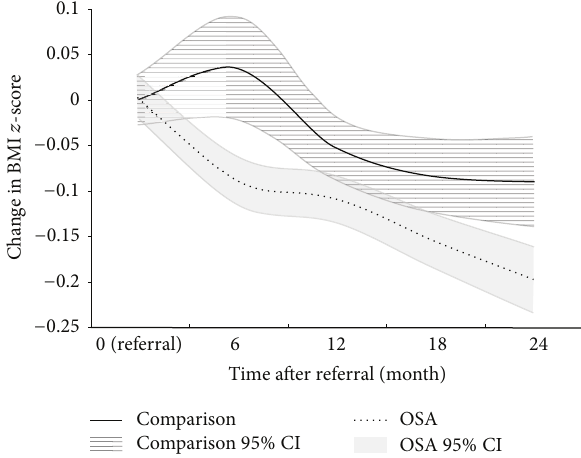
Figure 2: Change in BMI z -score after referral for OSA and comparison